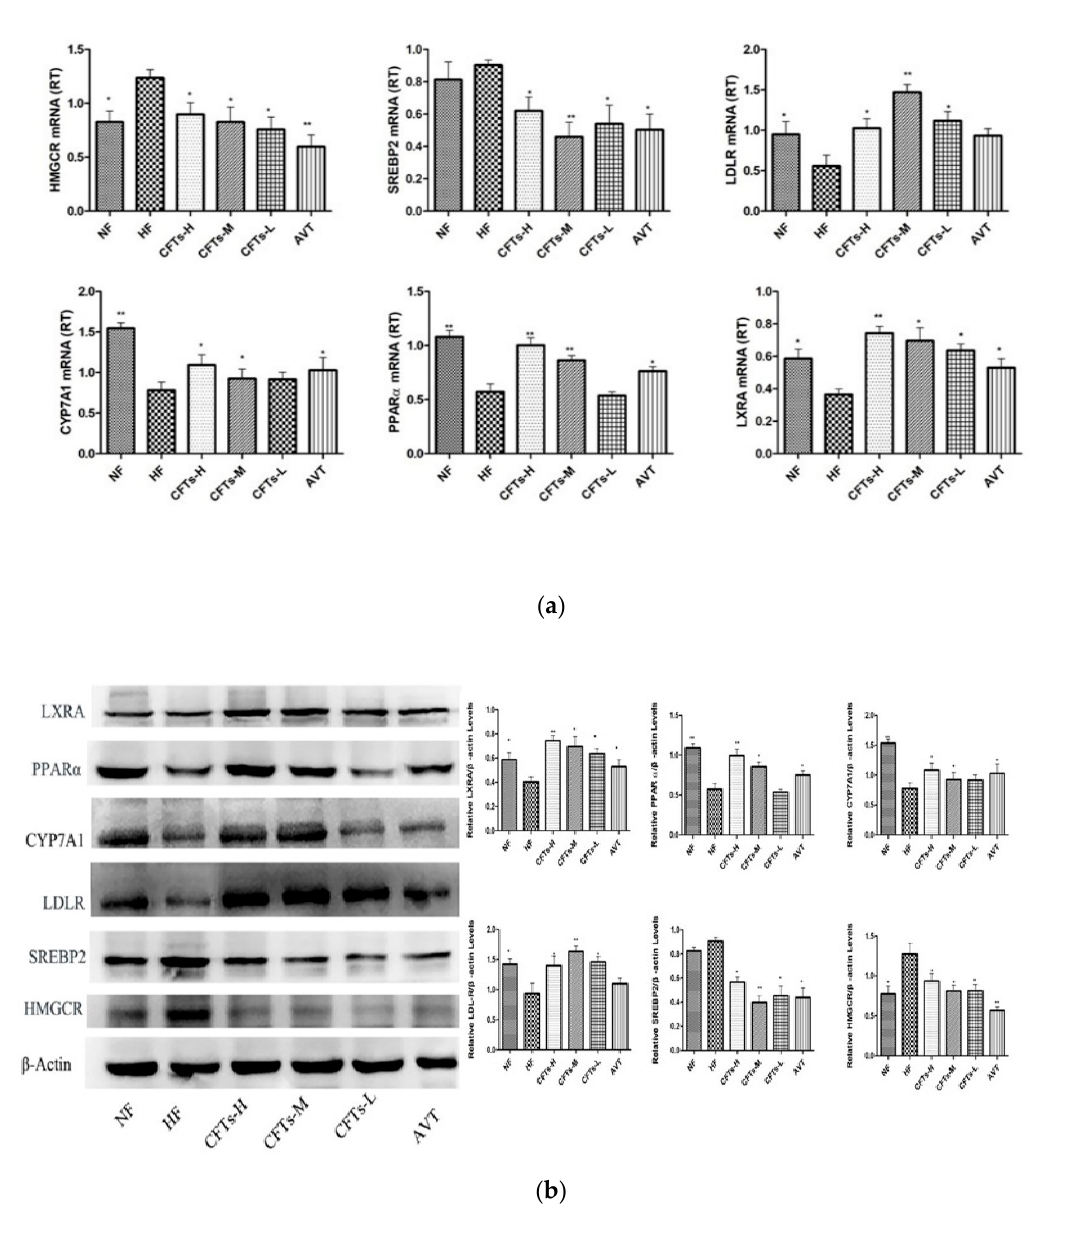
Figure 10. Effects of CFTs on hepatic genes expression. ( a ) Hepatic genes expression fold change in rats treated with CFTs for 6 weeks; ( b ) CFTs regulated expression levels of lipogenic genes. Compared to HF, * p < 0.05, ** p < 0.01.